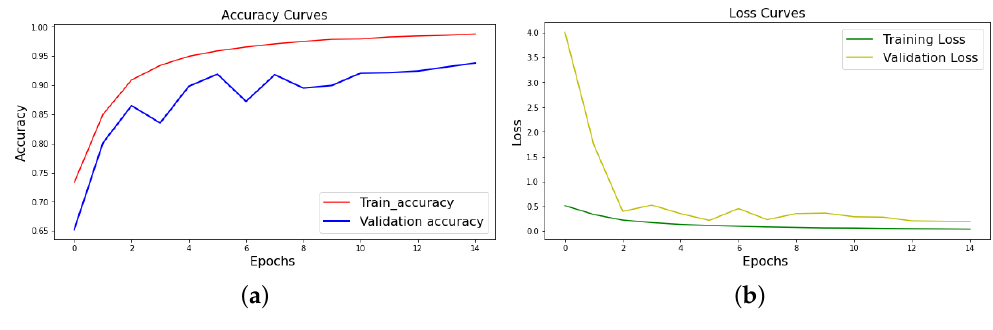
Figure 6. ( a ) Accuracy graph, ( b ) loss graph.